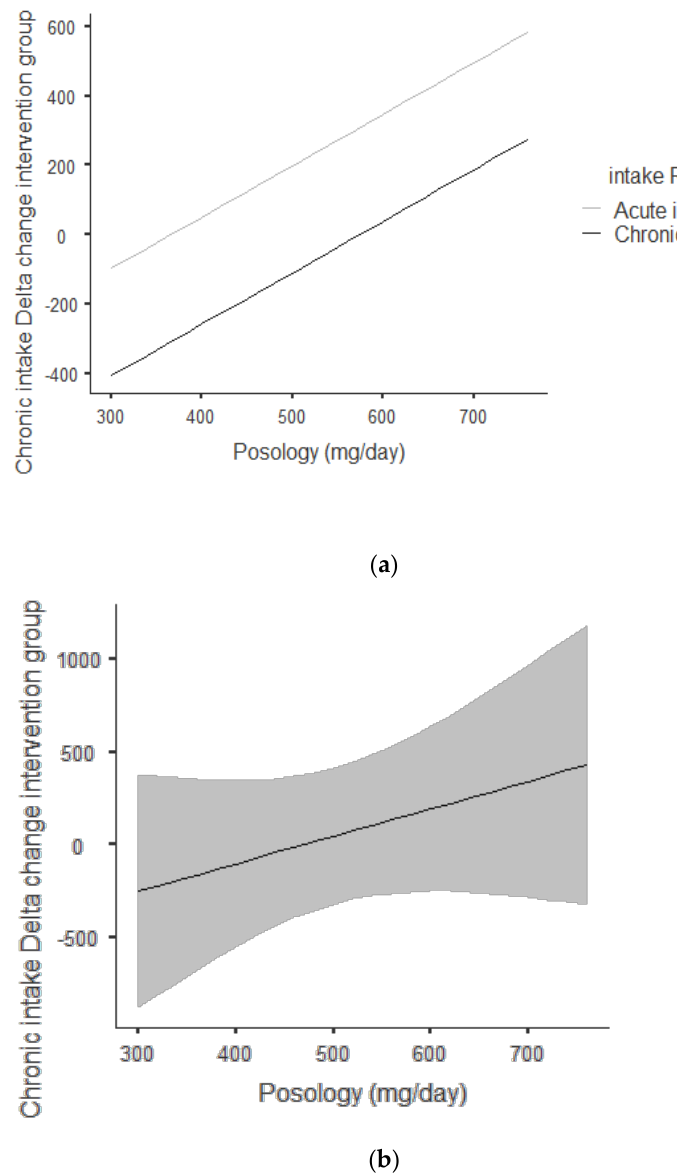
Figure 2. ( a ) Dose – response of acute and chronic green tea catechin intake on RMR. ( b ) Dose – response of green tea catechin intake on RMR.